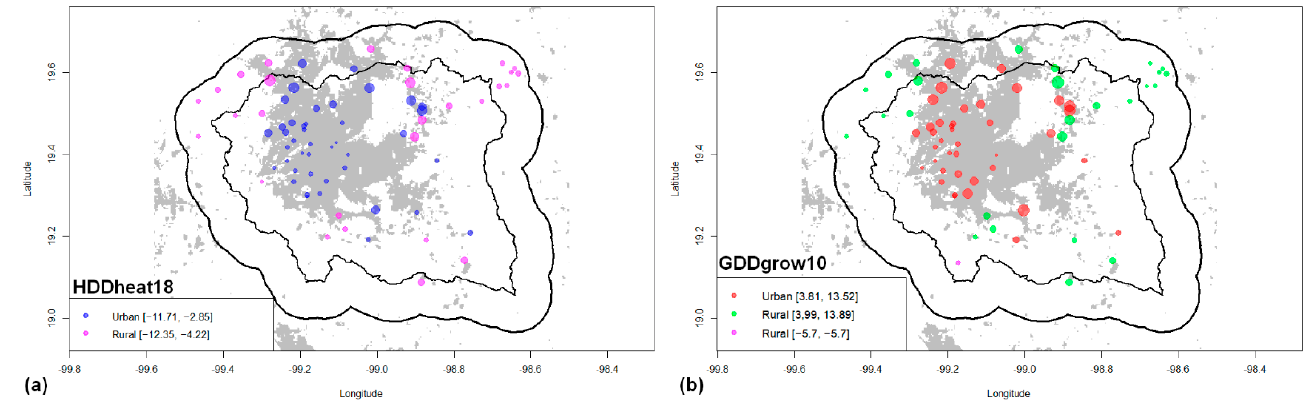
Figure 9. The same as in Figure 5 but for: ( a ) HDDheat18 (degree days/year), and ( b ) GDDgrow10 (degree days/year).